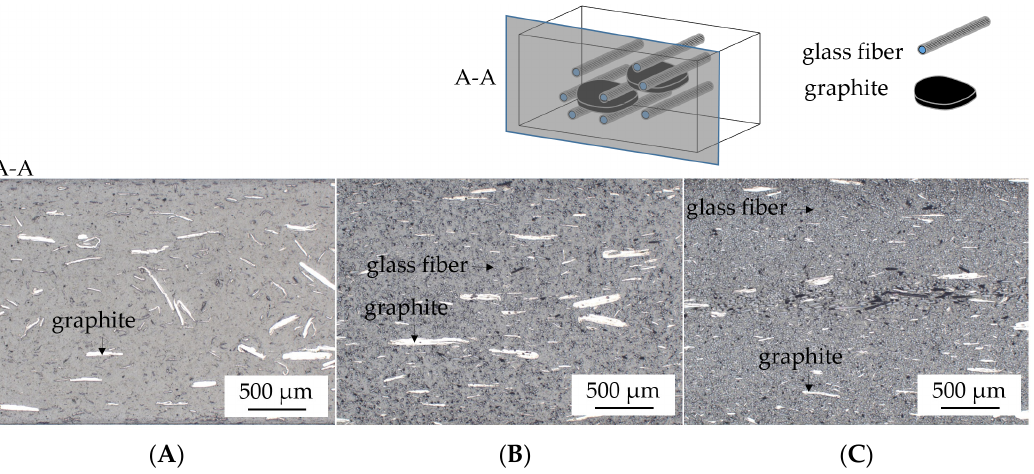
Figure 1. Microscopy images of ( A ) PA6 + 15 wt.% EG, ( B ) PA6 + 15 wt.% EG + 25 wt.% (15 vol.%) GF and ( C ) PA6 + 15 wt.% EG + 45 wt.% (30 vol.%).